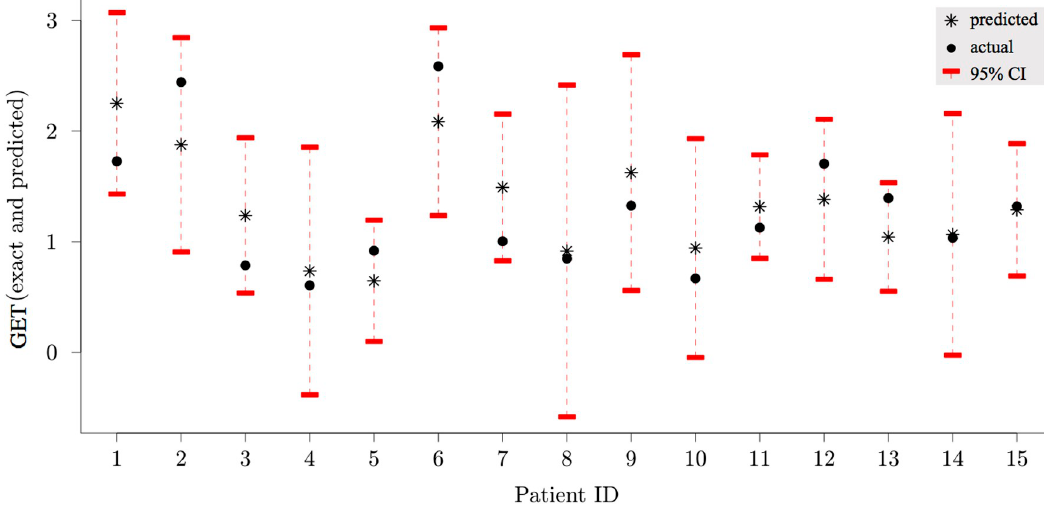
Fig 10. Predictions (asterisks) vs. exact values (bullets). Red bars show the 95% confidence intervals, m i (x i ) ± 1.96 s i (x i ) around the predicted value, where m i and s i are GP prediction mean and standard deviation based on all but the i ’th data point.